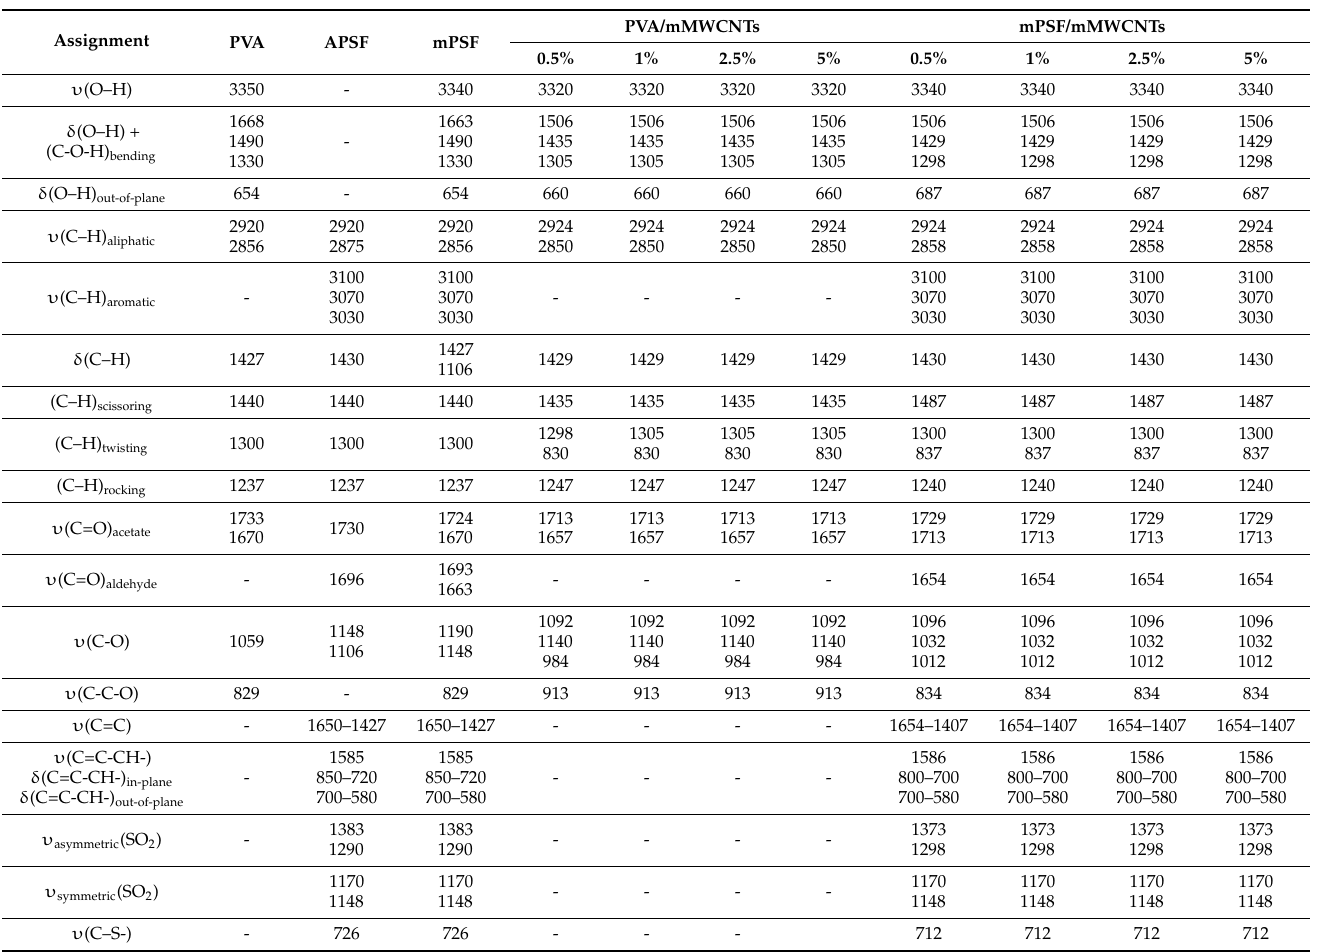
Table 1. Assignments of the IR characteristicbands of thePVA, APSF, mPSF, PVA/mMWCNTs, and mPSF/mMWCNTs